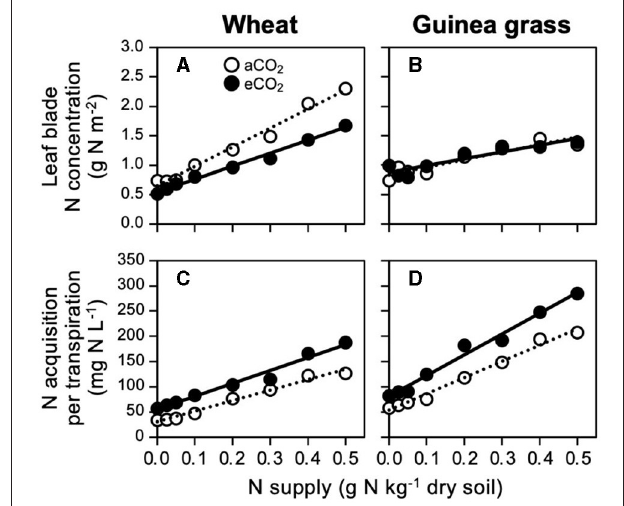
FIGURE 4 | Relationships between foliar N concentration (A,B) or N acquisition per transpiration (C,D) and nitrate-N supply in C 3 wheat and C 4 guinea grass grown for 28 d in the chambers under ambient (aCO 2 ) or elevated (eCO 2 ) CO 2 treatments.